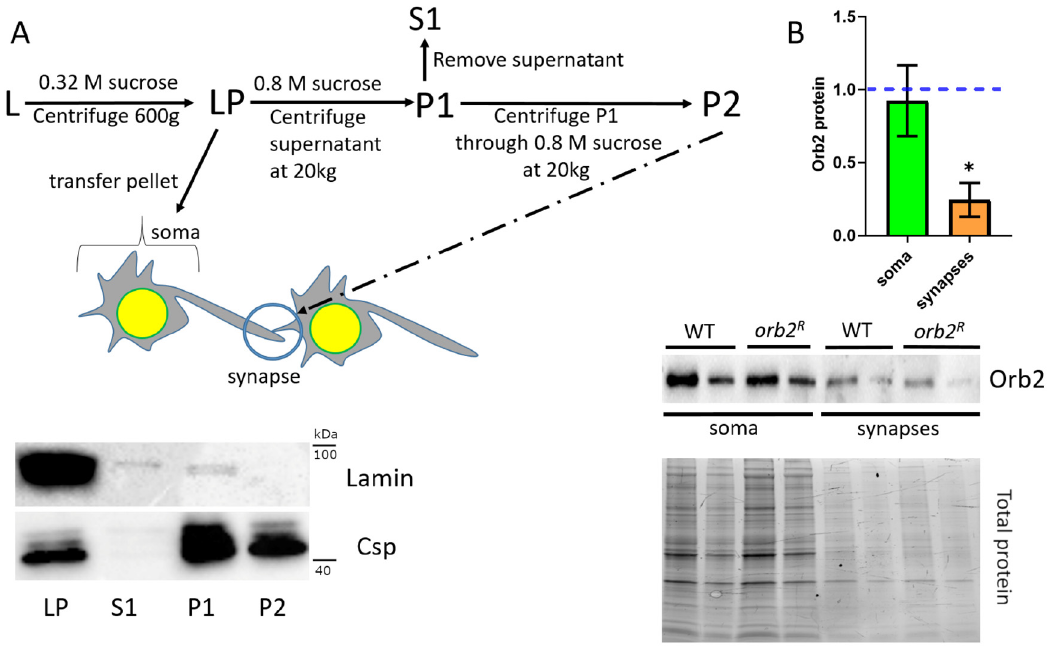
Figure 3. Distribution of the Orb2 protein in neurons. ( A ), top panel: Scheme of fractionation of the brain extract (see text for detail). ( A ), bottom panel: Western blot analysis of the fractions indicated in ( A ) with antibodies against Lamin and Csp. ( B ), top panel: The Orb2 protein contents in synapses and soma in WT and the orb2 R mutant. Error bars show standard deviation ( t -test, n = 10). A blue dashed line displays the relative protein levels in WT flies; bars show the levels in orb2 R flies. An asterisk shows the significant change ( p < 0.05) in protein levels in orb2 R flies compared with WT flies. ( B ), bottom panel: Western blot hybridization with antibodies against the Orb2 protein. LP (soma) and P2 (synaptic) fractions were analyzed. Each fraction was used in two two-fold dilutions (10 and 5 µL). Total protein staining was used for normalization.